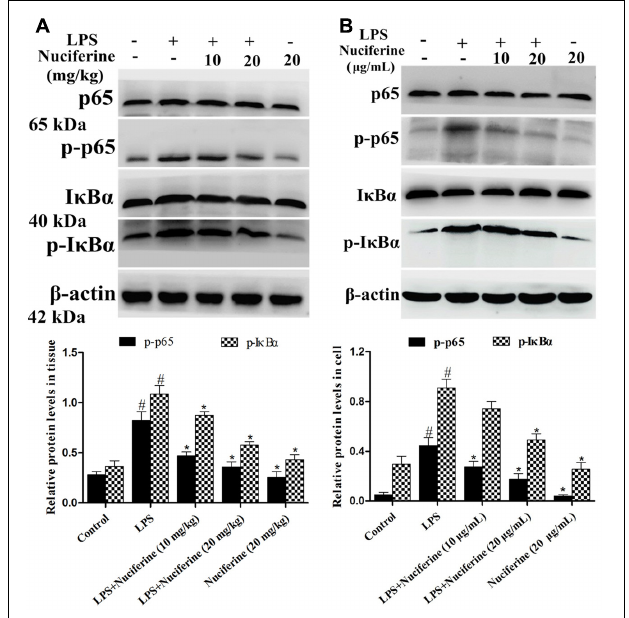
FIGURE 6 | Effects of nuciferine on NF- κ B pathway activation. (A) Expression of I κ B α and p65 proteins in LPS-induced acute lung injury. (B) Expression of I κ B α and p65 proteins in LPS-stimulated RAW264.7 cells. β -actin served as the control. These antibodies were both obtained from the Cell Signaling Technology [Phospho-NF- κ B p65 (Ser536) (93H1) Rabbit mAb, NF- κ B p65 (D14E12) XP R (cid:13) Rabbit mAb, Phospho-I κ B α (Ser32) (14D4) Rabbit mAb, I κ B α (L35A5) Mouse mAb]. Data are represented as the mean ± SEM of three independent experiments. # p < 0.05 vs. Control group, ∗ p < 0.05 vs. LPS